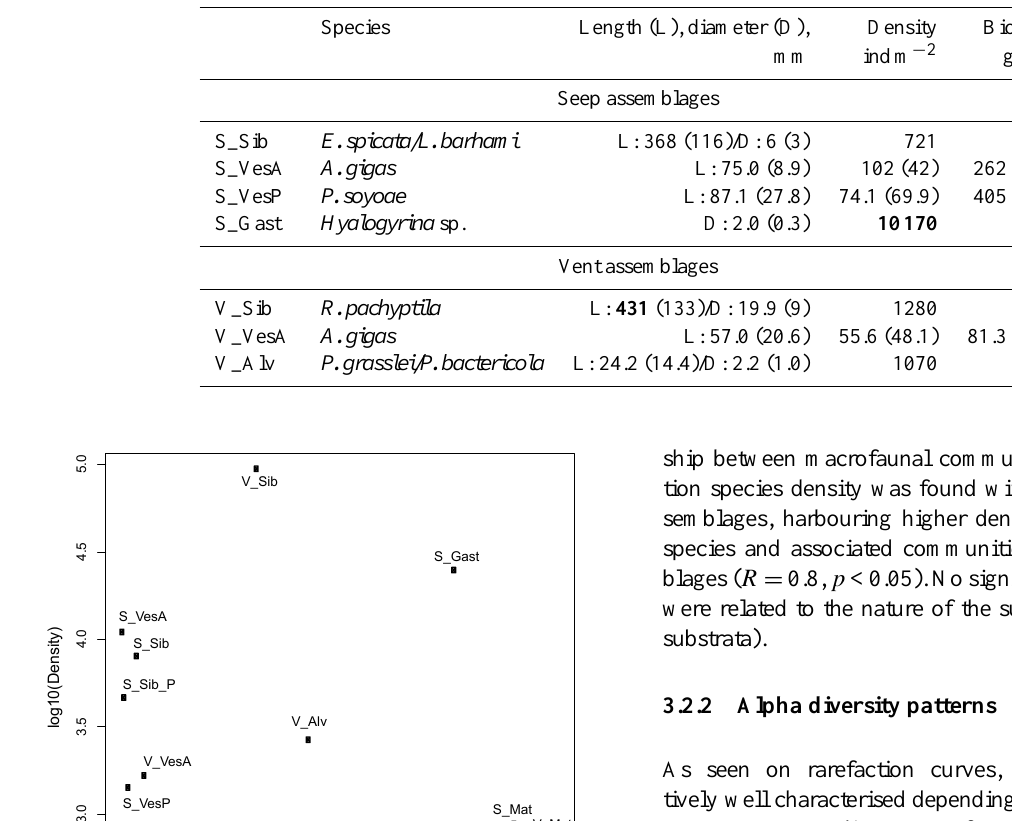
Table 5. Characteristics of foundation species (size, density and biomass) in the Guaymas Basin. Standard deviations are given in parentheses and highest values are shown in bold.